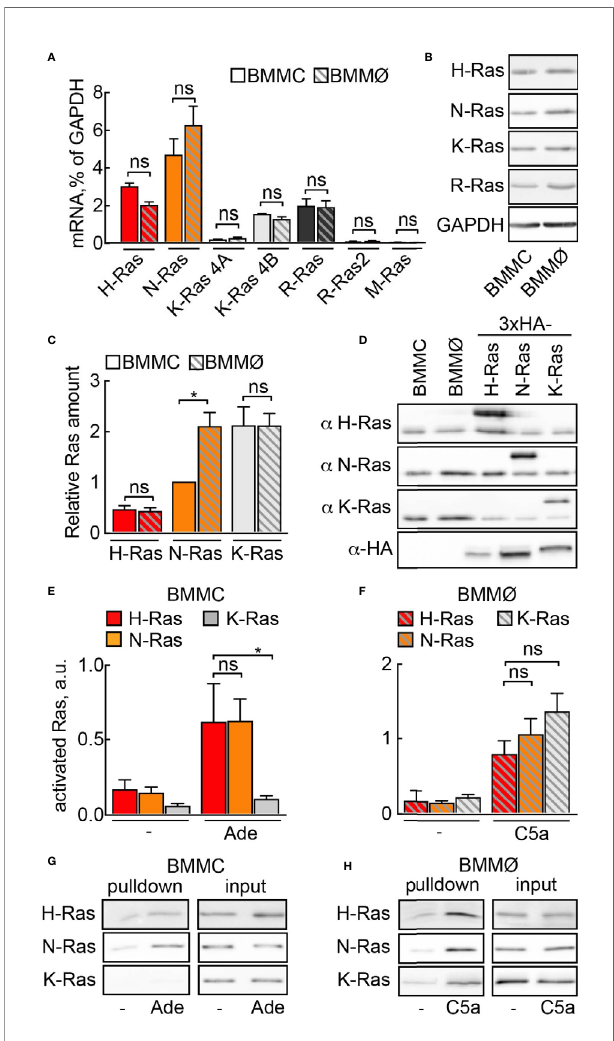
FIGURE 1 | Ras activation by GPCR ligands. (A) Relative mRNA abundance of N-Ras, K-Ras 4A, K-Ras 4B, H-Ras, R-Ras, R-Ras2 and M-Ras was assessed in BMMCs and BMMØs by qPCR and normalized to GAPDH expression level (n = 5 – 6). (B) N-Ras, K-Ras, H-Ras and R-Ras proteins were detected in BMMC and BMMØ lysates by Western blotting using corresponding isoform-speci fi c antibodies. (C) Quanti fi cation from n = 7 measurements of Ras isoforms in BMMCs and BMMØs, with N-Ras expression used as a reference point (=1). (D) Plasmids encoding HA-tagged codon-optimized N-, K-, and H-Ras were transfected into HEK293 cells. Protein expression levels of the three isoforms in HEK293 lysates were equalized using anti-HA antibodies. These lysates were then used as standards for quanti fi cation of relative amount of Ras isoforms in (C) . (E – H) Ras activation assay in BMMCs and BMMØs. Cells were starved in the corresponding starvation medium for 4 h before stimulation with 4 µM adenosine (Ade) (BMMC) or 10 nM C5a (BMMØ). GST-tagged Ras binding domain (RBD) of Raf1A was used to pull down GTP-loaded activated Ras. N- Ras, K-Ras, and H-Ras were subsequently detected in the pulled down fraction by Western blotting using isoform-speci fi c antibodies and presented as a percentage of total amount of the corresponding isoform in the lysate used for the pull-down experiment (input). (E, F) show quanti fi cations of n = 5 – 14 pull-down assays. Representative Western blot images are presented in (G, H). Statistical analysis was performed with one-way ANOVA and Bonferroni correction. Signi fi cance levels in all fi gures are indicated as non- signi fi cant (ns): p > 0.05; *p ≤ 0.05, **p ≤ 0.01, ***p ≤ 0.001; ****p ≤